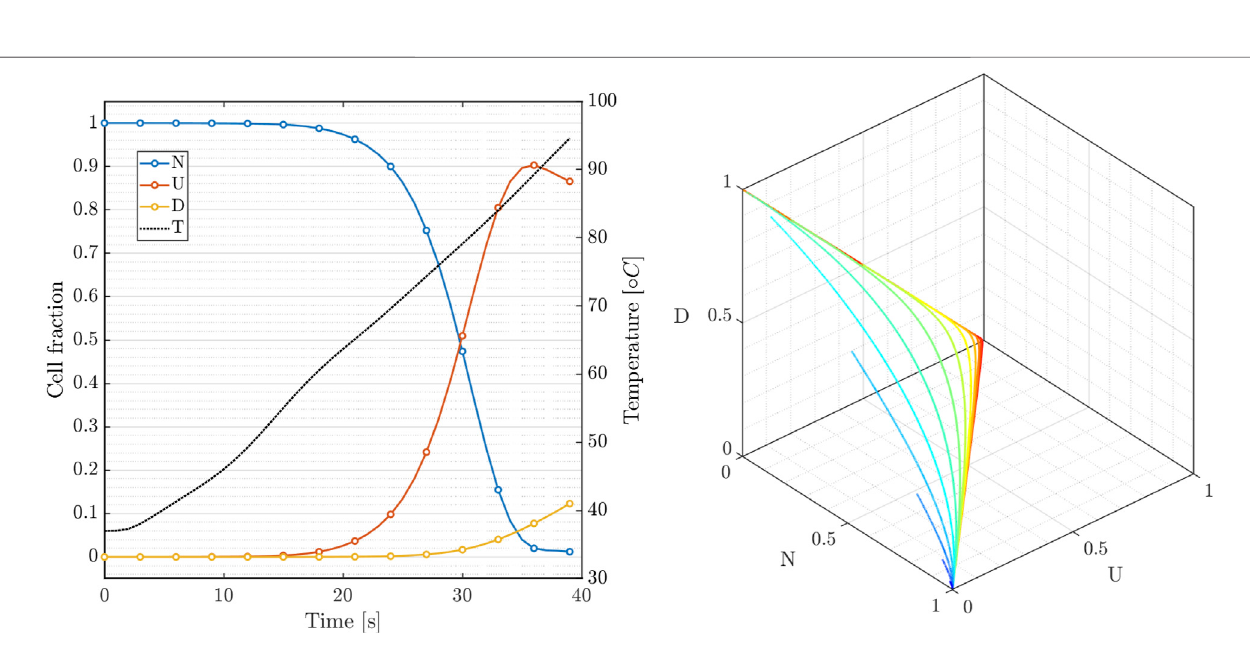
FIGURE 5 | Three-state cellular model: (left) variables dynamics during RF hyperthermic treatment; (right) N-U-D phase portrait of system 7 for constant temperature applied for 800s (40 ÷ 100 ° C).